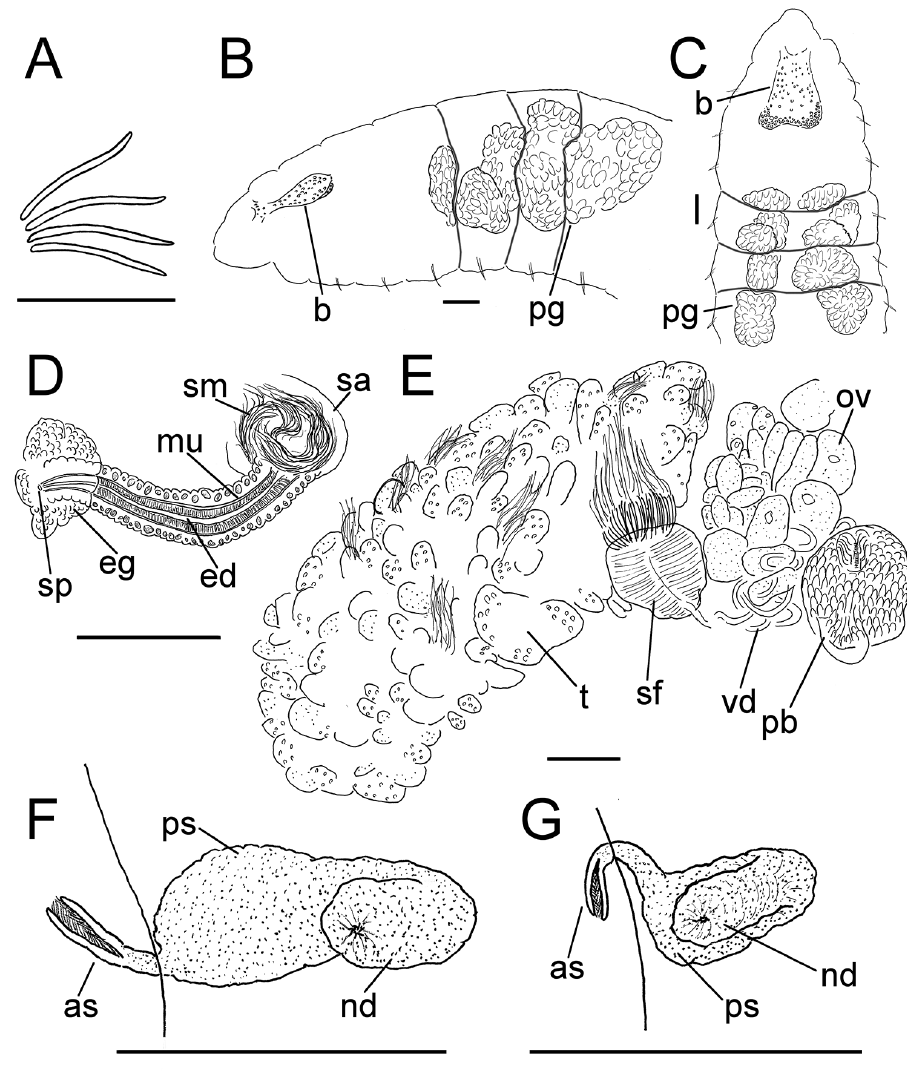
Figure 24. Claparedrilus semifuscoides sp. n. A Chaetal bundle B Anterior body C Anterior body dorsal view D Spermatheca E Other genitalia. F. Nephridium from XIV G Nephridium from XXIX in another individual. Abbreviations under general notes. Scale bars: 100